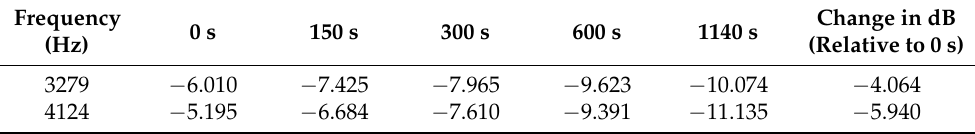
Table 1. Normalized magnitude in log scale for frequencies of 3279 and 4124